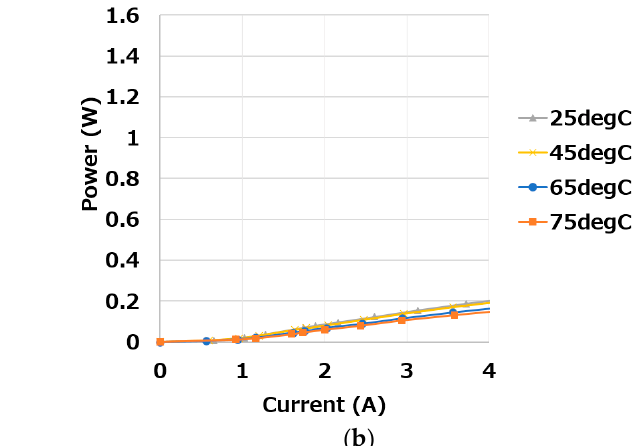
Figure 9. I – L characteristics of the SS-VCSEL on the Tx module at different temperatures under ( a ) one-block and ( b ) all-blocks emissions; the vertical axis in ( b ) is the output power per block. The SS-VCSEL output spectra of the Tx module at different temperatures obtained in the one-block and all-blocks emission modes are shown in Figure 10a,b, respectively. The current in the one-block and all-blocks emission modes were 2 A (49 mA/emitter) and 3.5 A (7 mA/emitter), respectively. The module was operated using a pulse width and duty cycle of 10 ns and 5%, respectively. The peak wavelengths during one-block emission and all-blocks emission at 25 ◦ C were 943.0 and 941.8 nm, respectively. Narrow spectrum widths of 0.6 and 0.27 nm were achieved in the one-block and all-blocks emission modes, respectively. The spectrum width of one-block emission modes is wider than that of all-blocks emission modes due to the number of transverse modes with higher injected current density. The wavelength shift owing to changes in temperature was 0.06 nm.